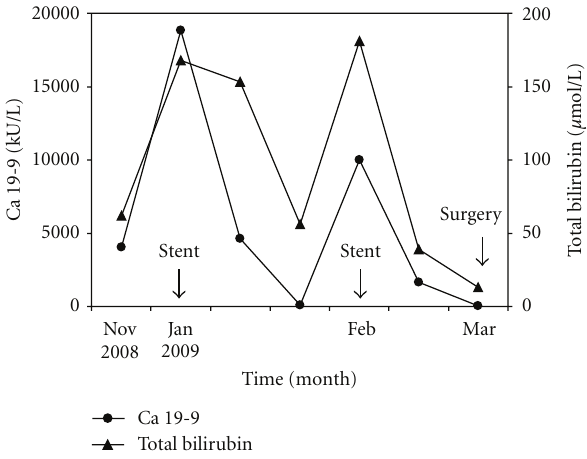
Figure 2: Serum Cancer Antigen 19-9 (CA 19-9) and total bilirubin concentrations in a 60-year-old female patient with obstructive jaundice due to a large biliary stone. Both markers rapidly decreased after endoscopic placement of a biliary endosprothesis. Surgery was performed in March